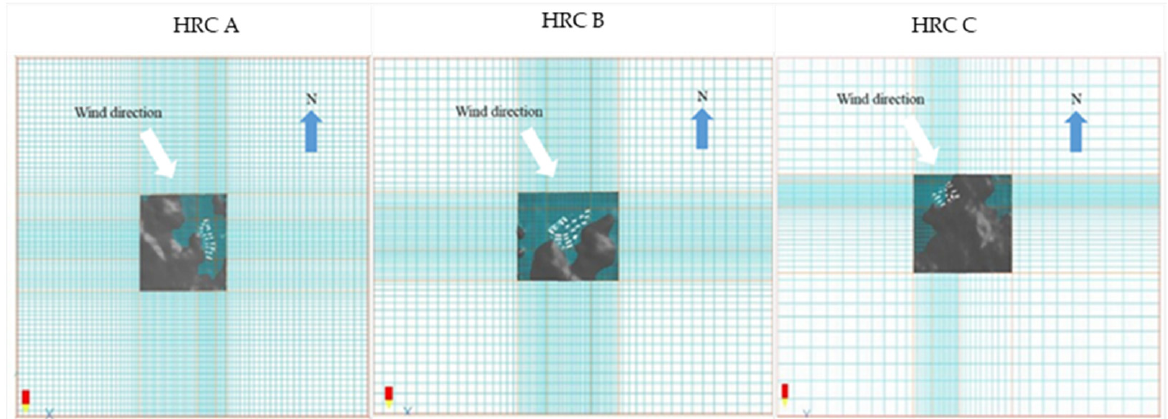
Figure 6. Meshes created in PHOENICS (A to C, from left to right).